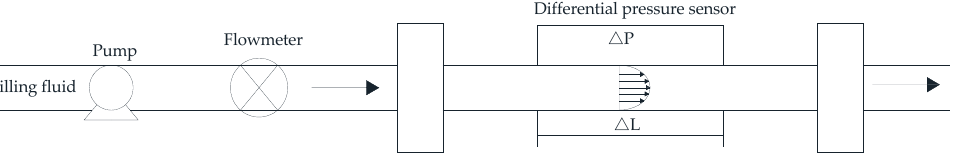
Figure 4. A schematic example of the pipe viscometer.